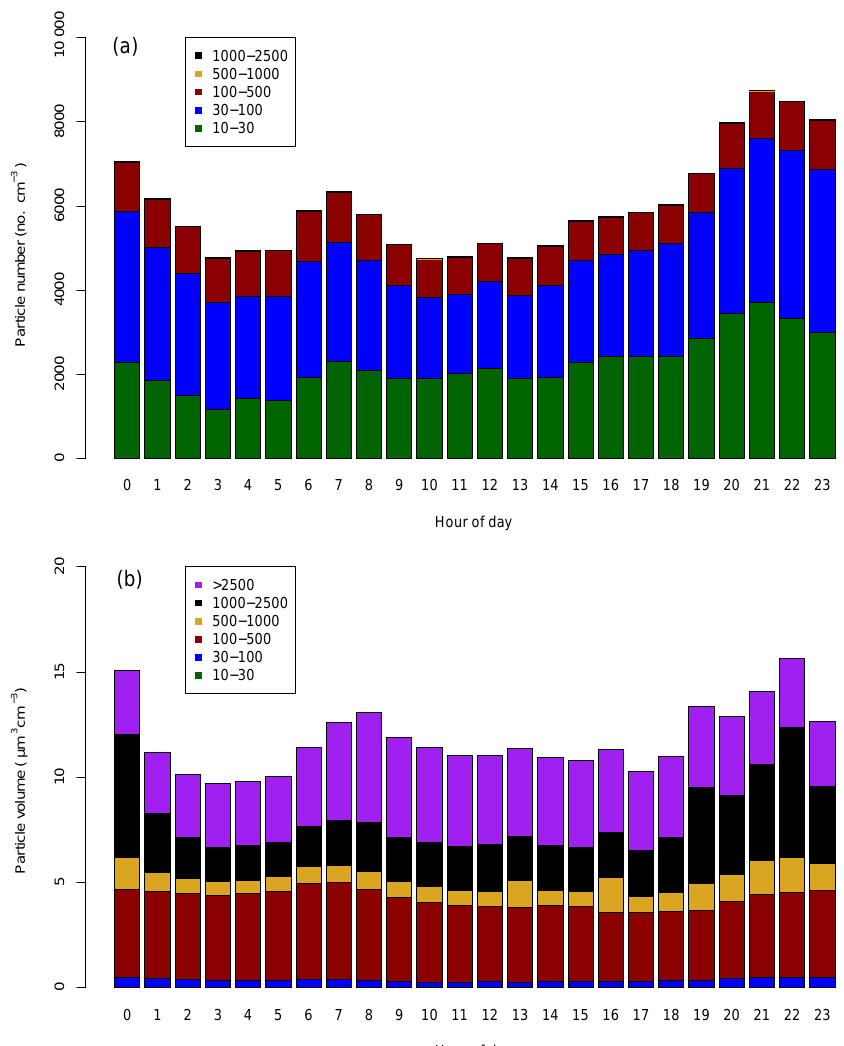
Figure 4. Mean diurnal cycles of the (a) particle number and (b) particle volume distributions at Neukölln. Legends show particle size bin range in